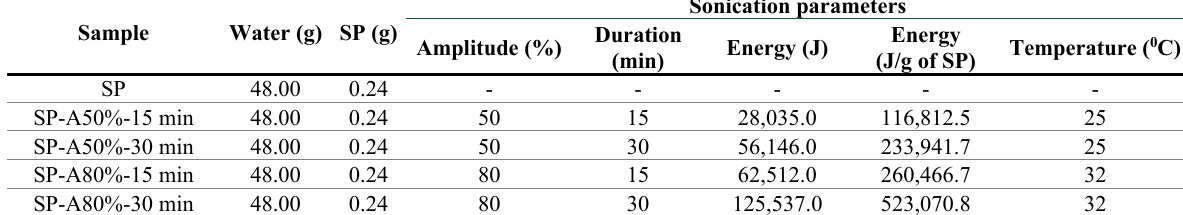
Table 3. SP aqueous dispersions